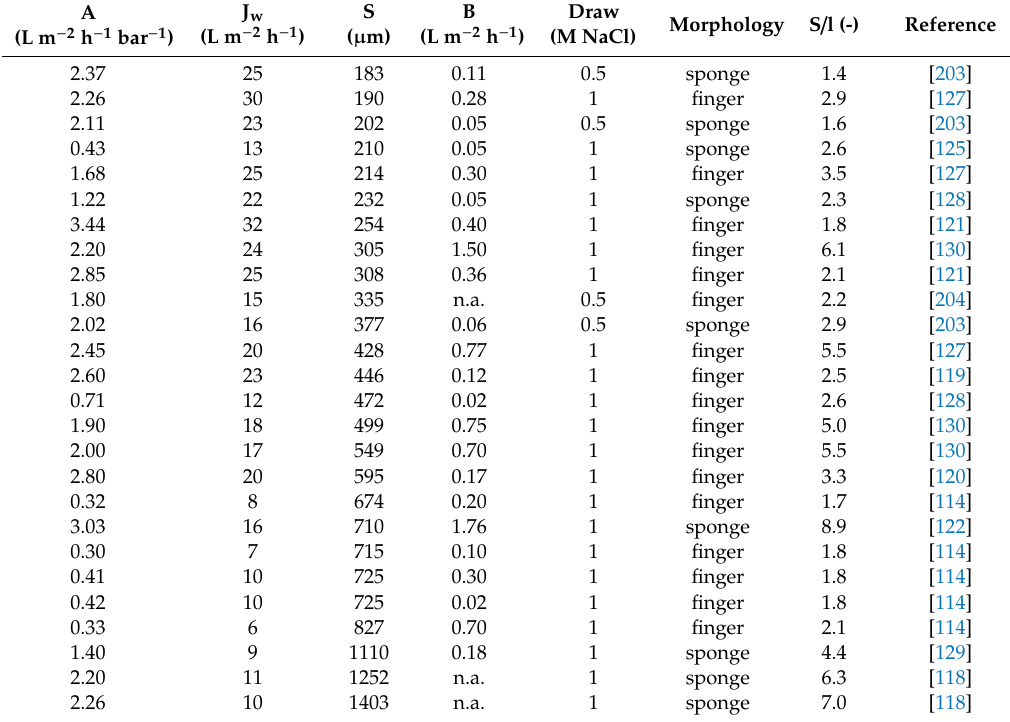
Table 1. Overview of hollow fiber FO membrane results published recently (data arranged based on S from low to